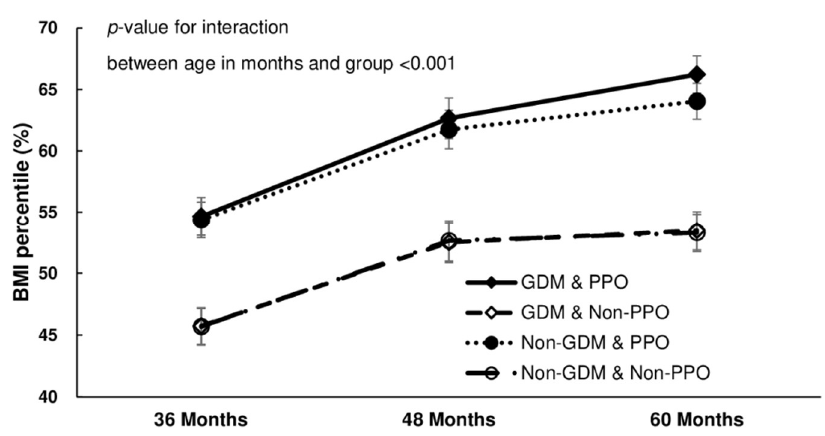
Figure 3. Body mass index percentile of the children according to age and group. BMI: body mass index, PPO: pre-pregnancy obesity, GDM: gestational diabetes mellitus. Table 2. Distribution of BMI percentile and prevalence of obesity according to maternal GDM and PPO.